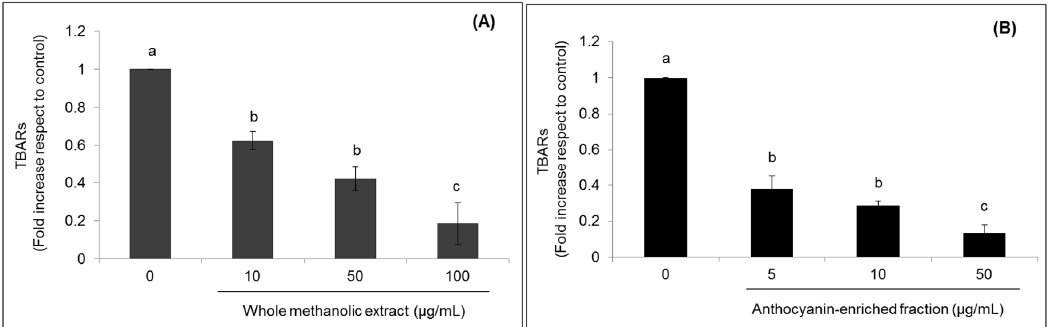
Figure 3. Effects of strawberry whole methanolic extract ( A ) and the anthocyanin-enriched fraction ( B ) on lipid peroxidation in HepG2 cells. Cells were treated with the indicated concentration of strawberry extracts for 24 h. The concentration of 0 µg/mL corresponds to the control (untreated cells). Values are expressed as the mean ± SD of three independent experiments ( n = 3). Columns belonging to the same set of data with different superscript letters are significantly different ( p < 0.05).